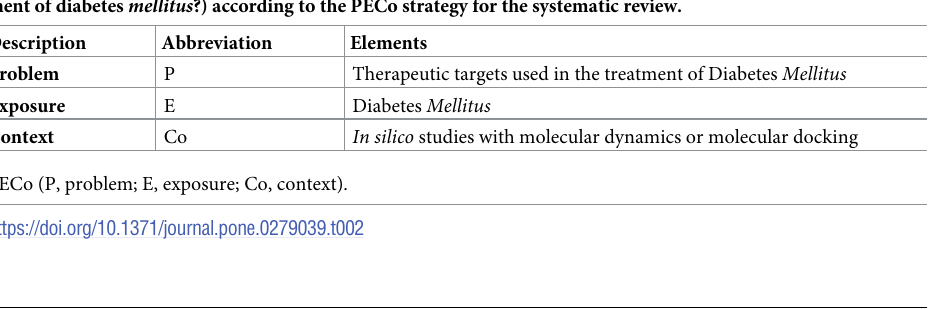
Table 2. Research question structure (What therapeutic targets have been used in in silico analysis for the treat- ment of diabetes mellitus ?) according to the PECo strategy for the systematic review.